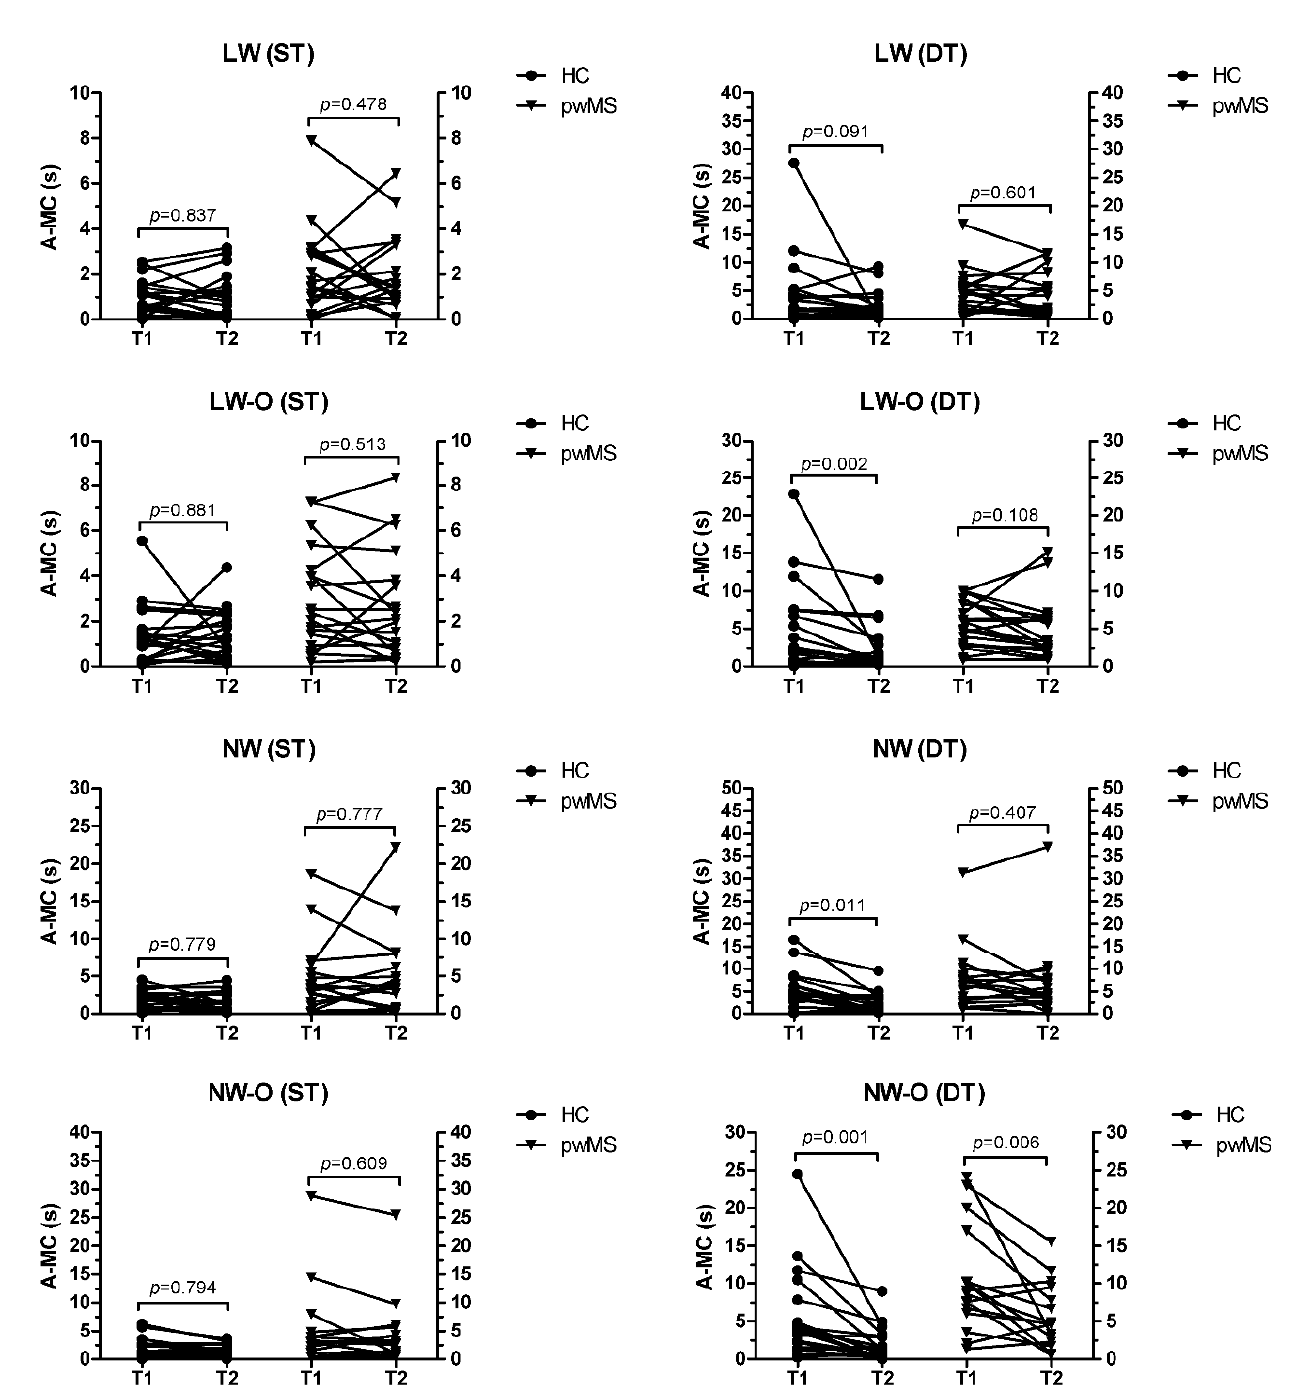
Figure 2. Changes in A-MC performance after actual execution of the walking tasks. Legend: A-MC: absolute mental chronometry; HC: healthy controls; pwMS: people with multiple sclerosis; LW: large-width walkway; LW-O: large-width walkway with obstacles; NW: narrow-width walkway; NW-O: narrow-width walkway with obstacles; ST: single-task; DT: dual-task; T1: trial 1 (pre-walking); T2 trial 2 (post-walking).